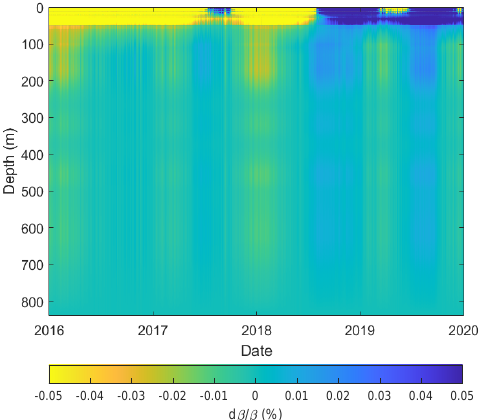
Figure 4. Modeled shear—wave velocity change in accordance with Equation (12) and Figures 2e,g and